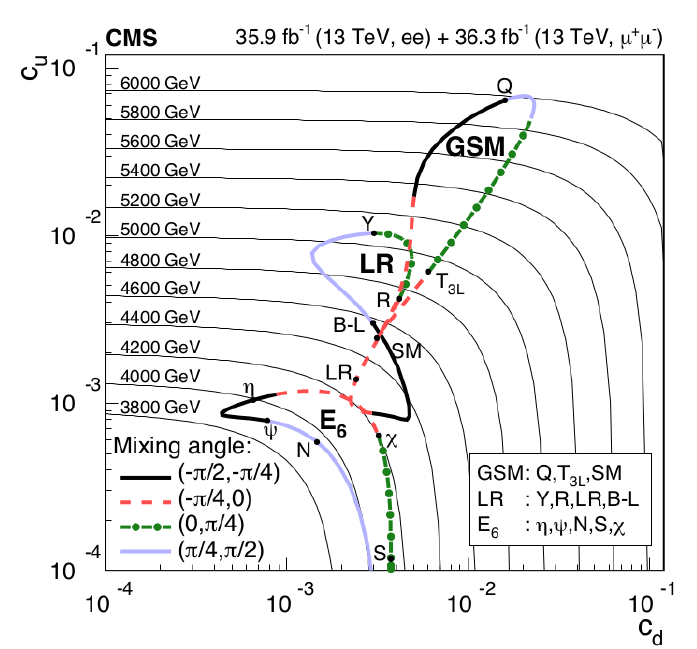
Figure 5 . Limits in the ( c d ; c u ) plane obtained by recasting the combined limit at 95% CL on the Z 0 boson cross section from dielectron and dimuon channels. For a given Z 0 boson mass, the cross section limit results in a solid thin black line. These lines are labelled with the relevant Z 0 boson masses. The closed contours representing the GSM, LR, and E 6 model classes are composed of thick line segments. Each point on a segment corresponds to a particular model, and the location of the point gives the mass limit on the relevant Z 0 boson. As indicated in the bottom left legend, the segment line styles correspond to ranges of the particular mixing angle for each considered